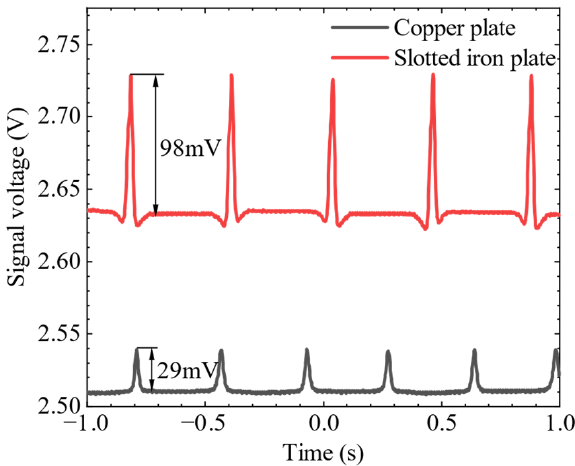
Figure 16. MFL signal in lift-off layer of copper plate and slotted iron plate.